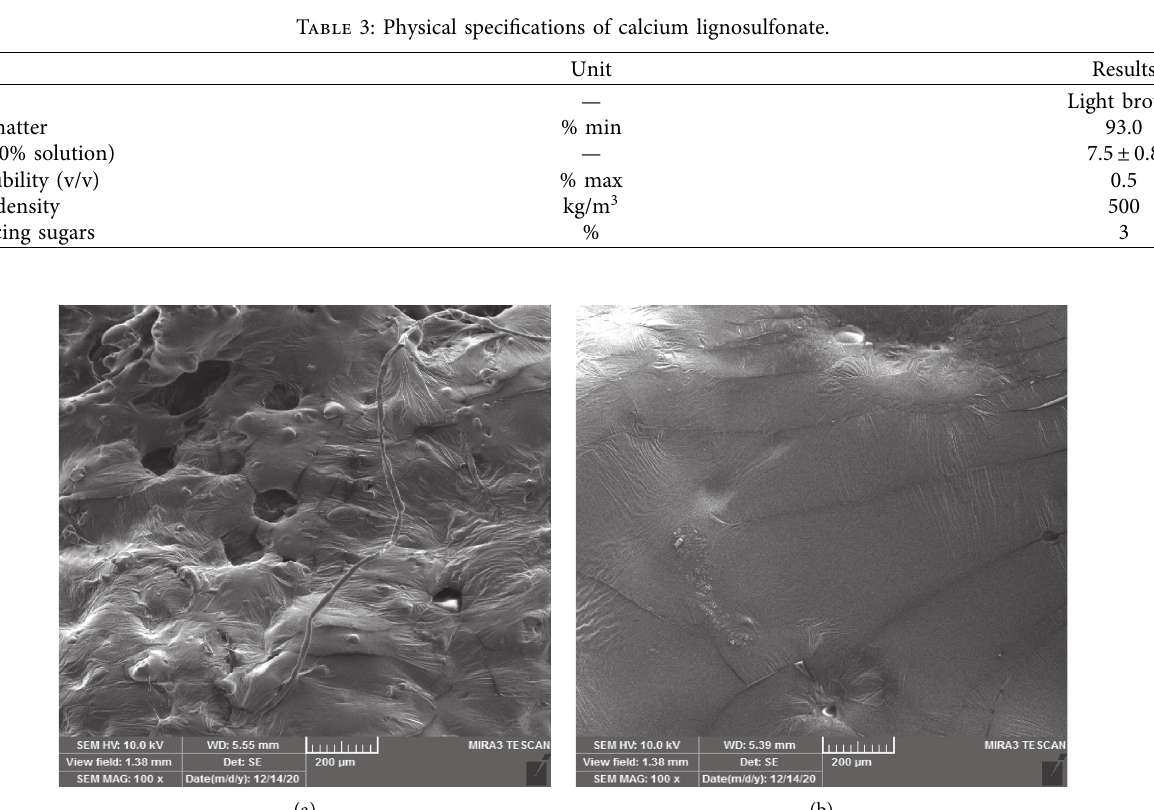
Figure 2: The FESEM images were taken at 100x zoom of (a) the 20% CL-modified asphalt binder and (b) the neat asphalt